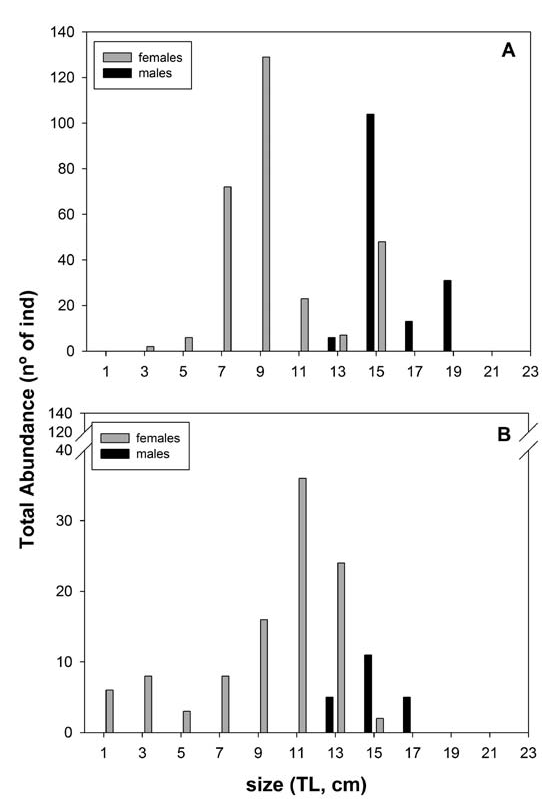
Fig. 3. – Total number of individuals of the pearly razorfish, Xy- richtys novacula , for each size class and sex recorded through UVCs (A) and SNs (B).